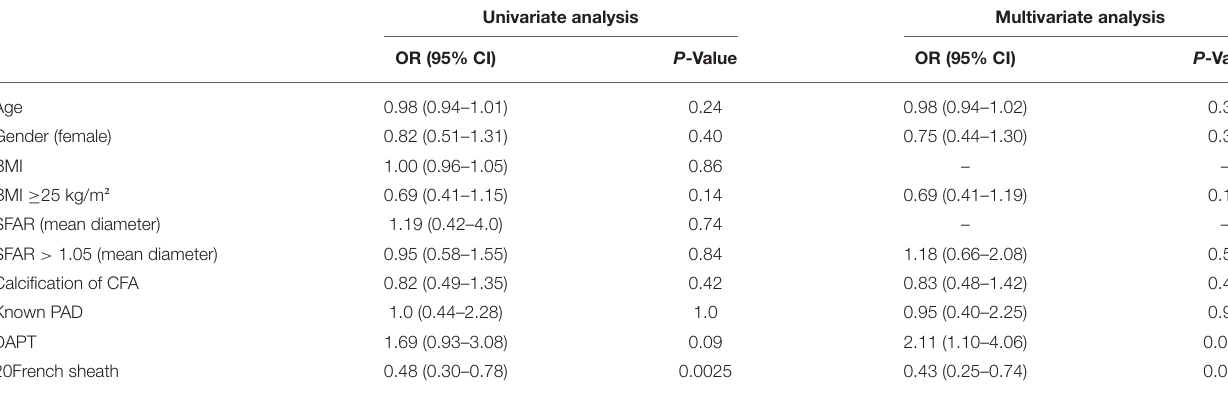
TABLE 5 | Predictors of vascular